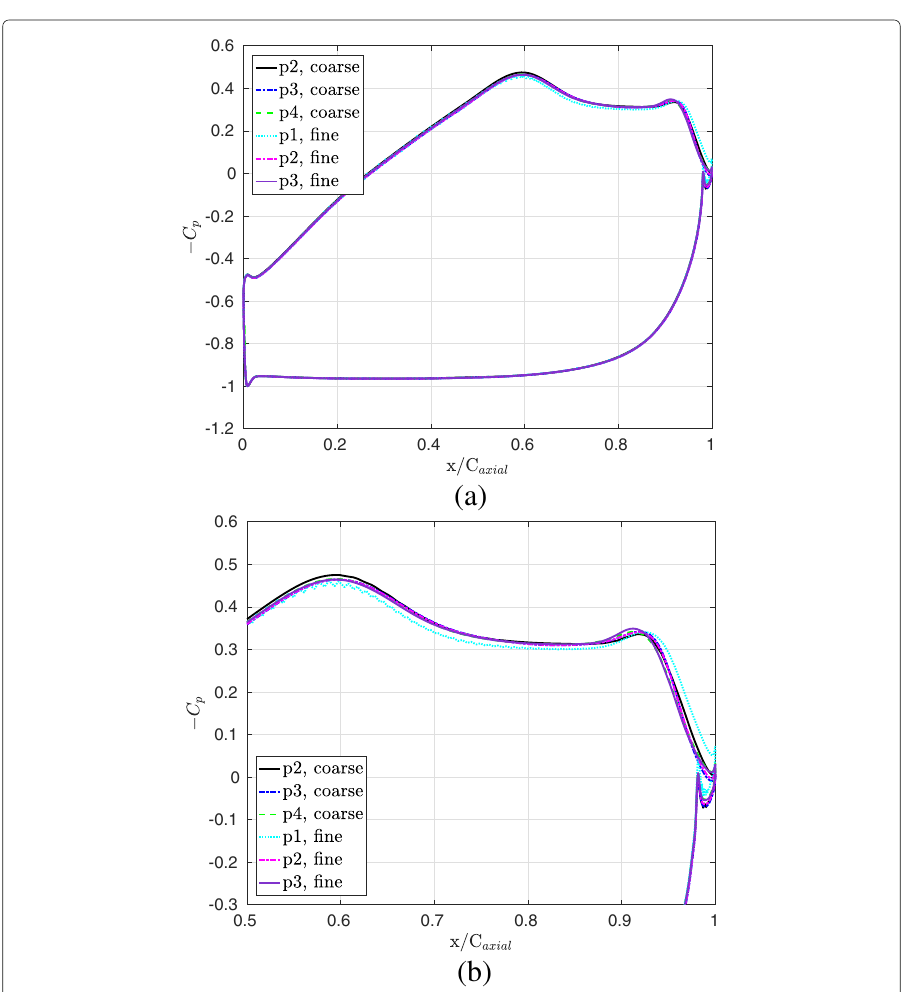
Fig. 5 Comparison of the time- and spanwise-averaged coefficient of pressure for all meshes and polynomial orders. ( a ) global view over the blade ( b ) enlarged view near the trailing edge